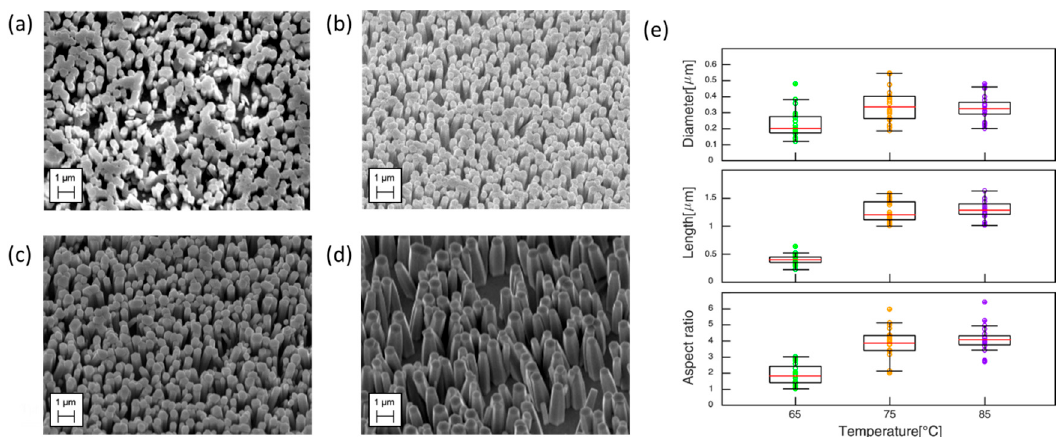
Figure 5. SEM images of seedless grown ZnO nanorods on annealed Au-coated Si substrate at four different temperatures ( a ) 65 °C, ( b ) 75 °C, ( c ) 85 °C and ( d ) 95 °C. ( e ) Boxplots displaying median values and interquartile ranges of diameter, length and aspect ratio of the rods grown at 65 °C, 75 °C and 85 °C.